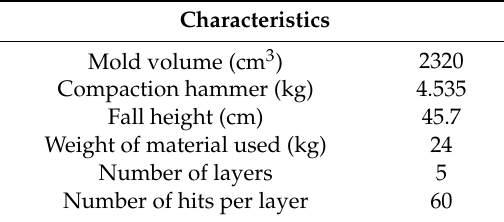
Table 5. Modified Proctor test characteristics.